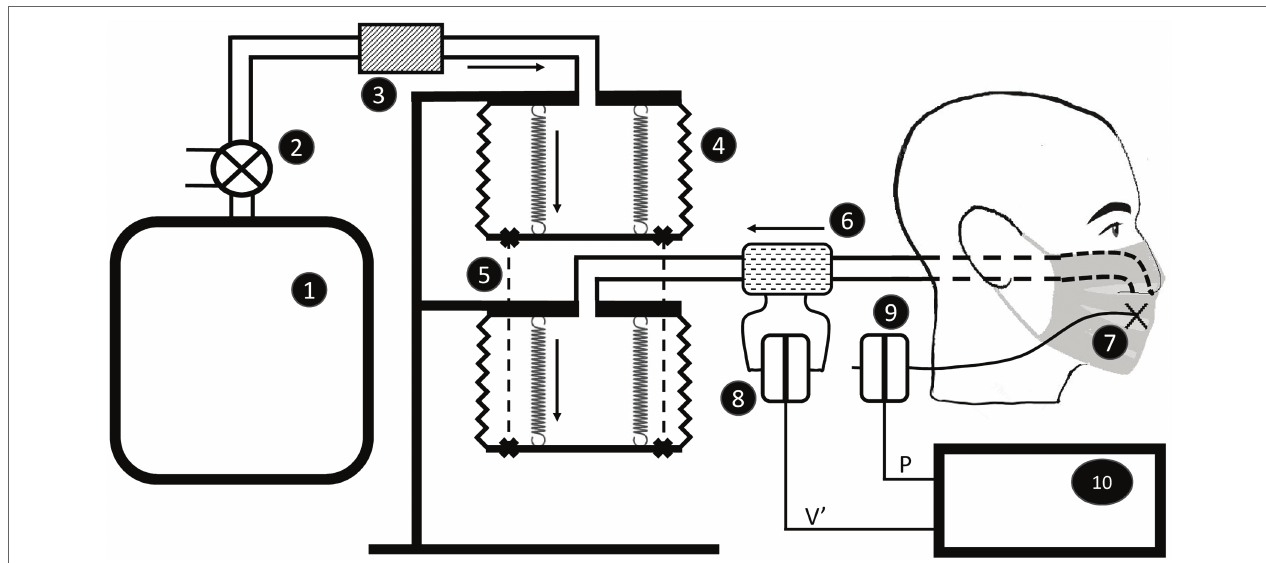
FIGURE 1 | Sketch of the apparatus to measure resistance of the face mask secured on the dummy head. The respirator (1) is connected through a valve (2) and a resistor (3) to bellows (4) attached through rails and springs (5). The second bellow is connected through a pneumotachograph (6) to the mock airways. Pressure is measured at four different points behind the mask (7). Flow (8) and pressure (9) signals are fed to a chart lab recorder (10). Dark arrows indicate the direction of flow during